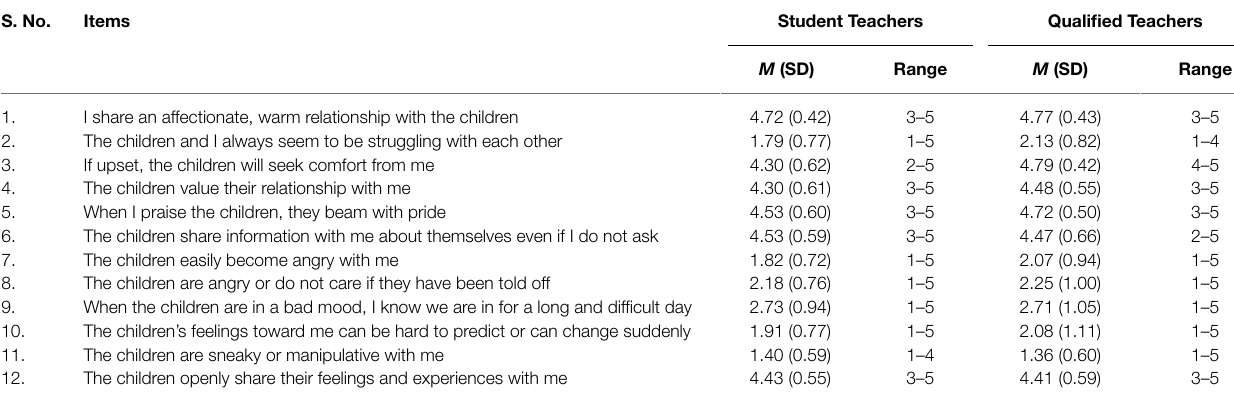
TABLE 2 | Closeness and Conflict items: descriptive statistics and reliability